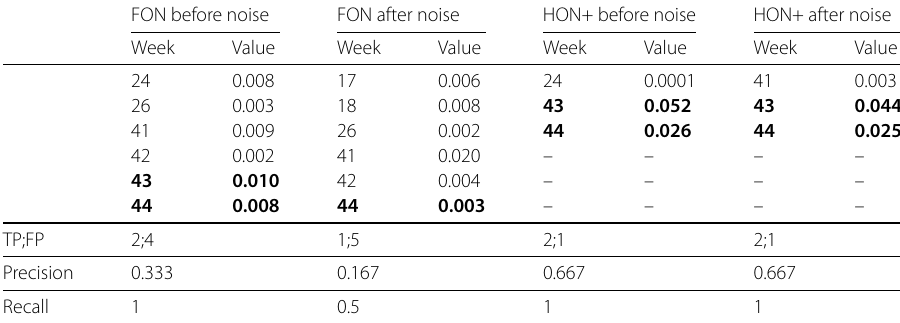
Table 1 Represents all the data points in which the graph distance (using FON and HON+) falls outside the 2 σ threshold. The column “value” indicates the difference between the graph distance (obtained from FON or HON+) and the closest 2 σ threshold (with respect to the moving average). TP refers to true positive values (correct anomalies), which are marked as bold. FP refers to false positive values. HON+ correctly detects anomalies, results in much lower false positives, and is more robust in presence of